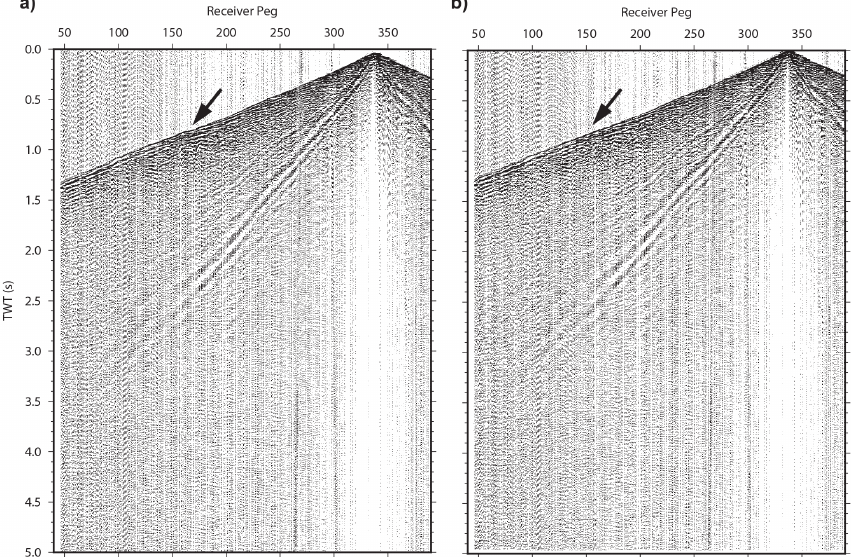
Figure 3. A shot gather (a) before refraction static correction (step 5; see Table 2) and (b) after the correction. The black arrow shows first arrivals which are improved and aligned after static